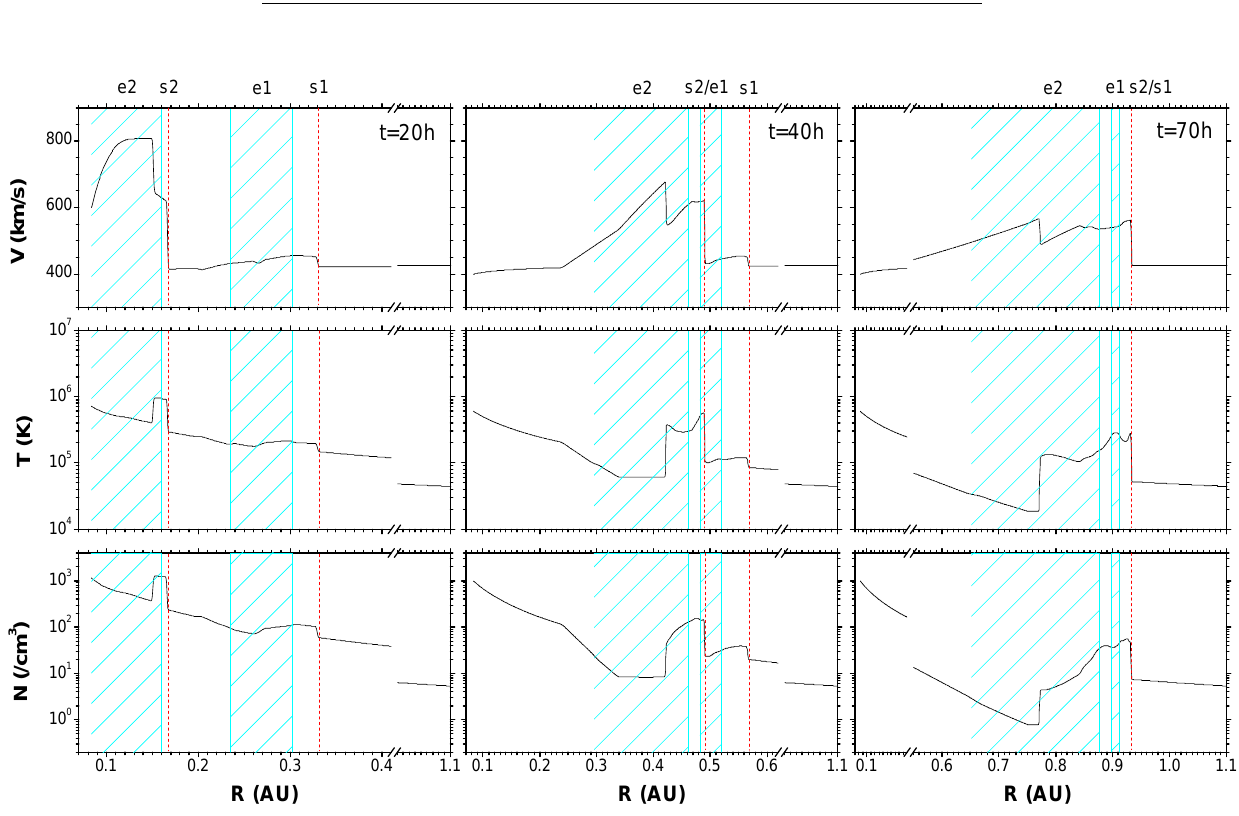
Fig. 2. Heliocentric evolution of two ejecta propagating in the solar wind at three different times after ejecta 1 initiation. The cases show the location of the two ejecta (e1, e2) and the vertical lines their shock waves (s1, s2). The scales on the horizontal axes were modified for each time to focus on the